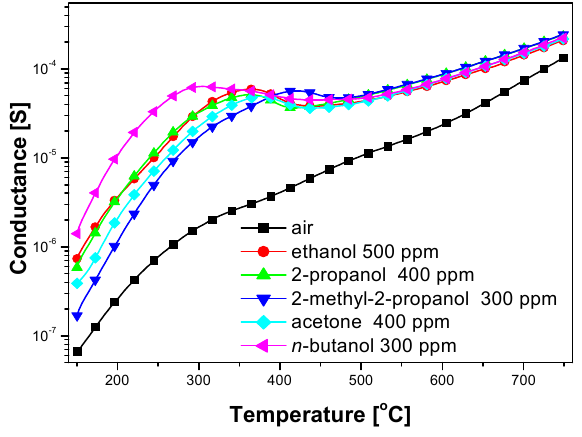
organic compounds.